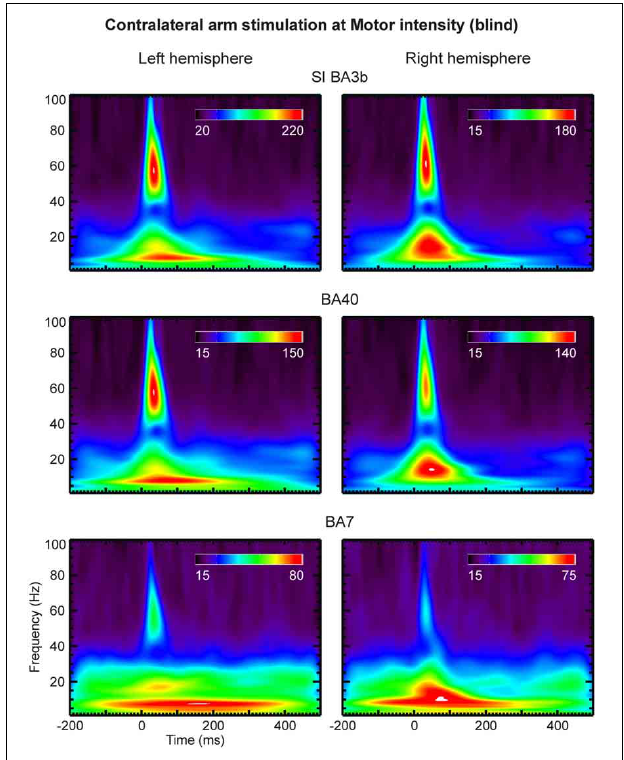
FIGURE 9 | The same as the Figure 8, but for the blind